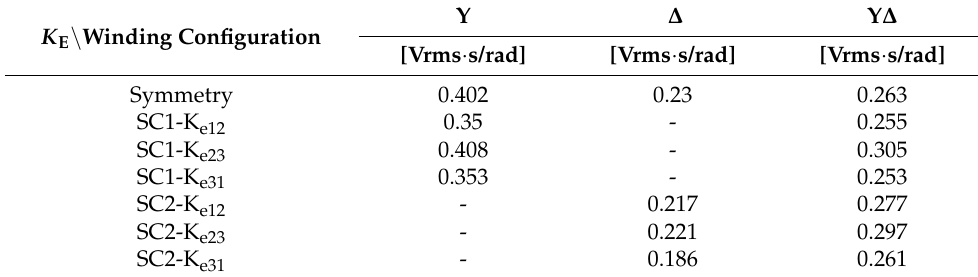
Table 3. Voltage constant K